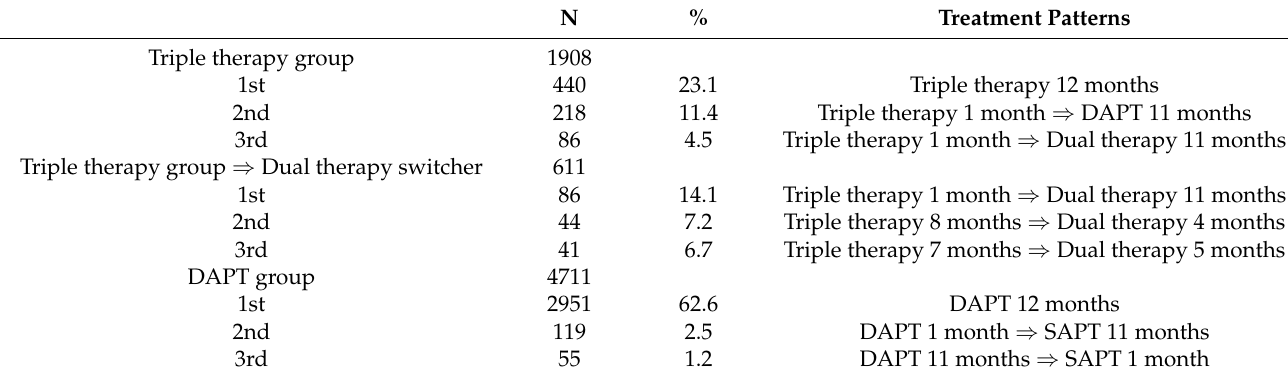
Table 2. Top three treatment patterns in patients with triple therapy or